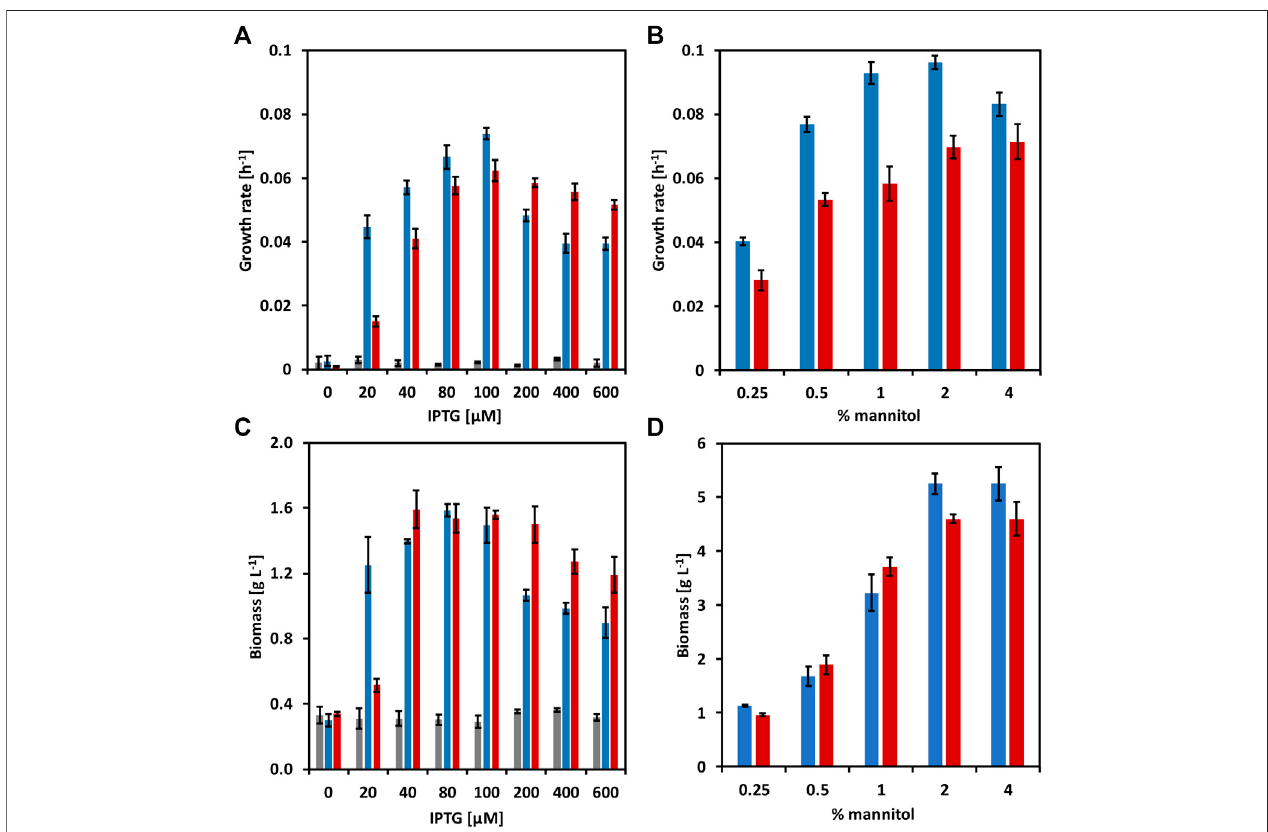
FIGURE 3 | Growth behavior of the strains CgSW10, CgSW11, and CgSW12 with mannitol as sole carbon source. (A) Growth rates of CgSW10 (grey columns), CgSW11 (blue columns), and CgSW12 (red columns) strains grown in 0.5% mannitol minimal medium supplemented with different concentrations of IPTG. (B) Growth rates of CgSW11 and CgSW12 strains grown in minimal medium supplemented with different concentrations mannitol and 100 µM of IPTG. (C) Final biomass of CgSW10, CgSW11, and CgSW12 strains grown in 0.5% mannitol minimal medium supplemented with different concentrations of IPTG. (D) Final biomass of CgSW11andCgSW12strainsgrowninminimalmediumsupplementedwith100 µMofIPTGanddifferentconcentrationsofmannitol.Meansandstandarddeviationsof triplicates are